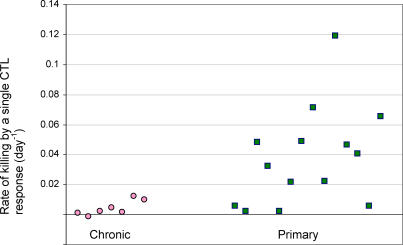
The Rate of CTL Killing Is Significantly Lower in Individuals with Long-Term InfectionIndividuals with chronic infection (filled circles) have weaker single CTL responses than individuals with primary infection (filled squares). The median rate of lysis of productively infected cells was 0.008 d
−1 in chronic infection and 0.04 d
−1 in primary infection. The rate of CTL lysis was significantly lower in individuals with long-term infection (Wilcoxon–Mann-Whitney
p = 0.004 two-tailed). Chronic infection was defined as infection in which the viral set point has been attained; primary infection as early infection prior to stabilisation of viral load which will include both seropositive and seronegative individuals.